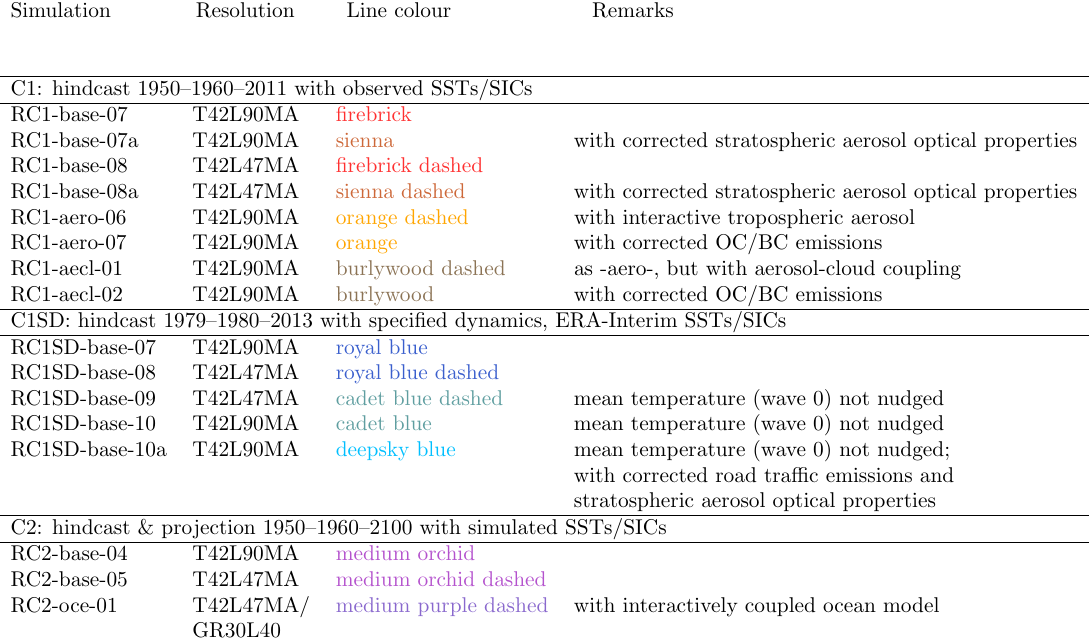
Table 1. Overview of ESCiMo reference simulations. The CCMI notation Ref-C1/2 is abbreviated with RC1/2, SD denotes specified dynam- ics. Different model configurations are indicated by -base-, -aero-, -aecl- and -oce-. The two digit numbers indicate the specific simulations (e.g. to distinguish the vertical resolution and specific SD set-up). An appended letter “a” indicates a sensitivity study (see remarks and Sect. 3.12). For detailed explanations, see text. The line colours refer to the figures below.